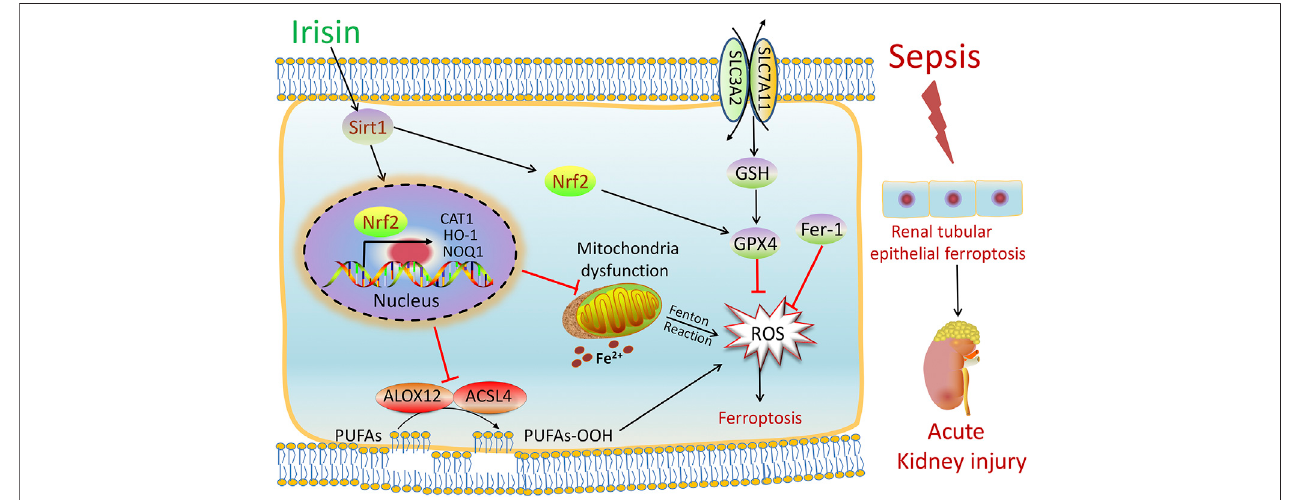
FIGURE 7 | Scheme summarizing the protective effects of irisin post-treatment on sepsis-associated acute kidney injury (SA-AKI) via induction of the SIRT1/Nrf2 signal axis. SA-AKI leads to increased iron and lipid peroxidation, along with GSH depletion, which is implicated in the pathological process of SA-AKI. Irisin post- treatment effectively suppressed ferroptosis and alleviated SA-AKI and improved mitochondrial function via induction of the SIRT1/Nrf2 signal axis. The ferroptosis- speci fi c inhibitor ferrostatin-1 (Fer-1) and the ferroptosis inducer Fe-citrate (Fe) could attenuate or exacerbate ferroptosis in SA-AKI, respectively.